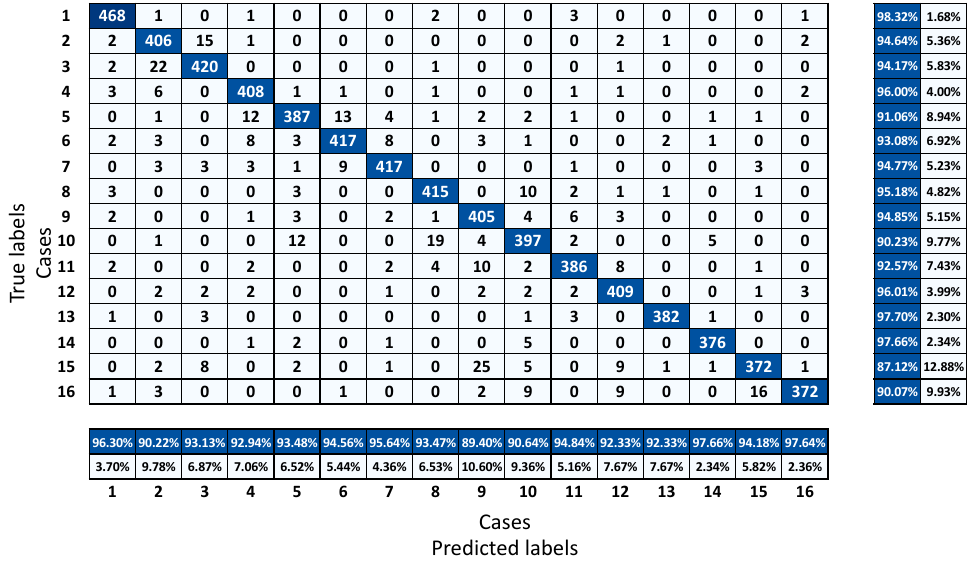
Figure 10. Confusion matrix of RF classifier.